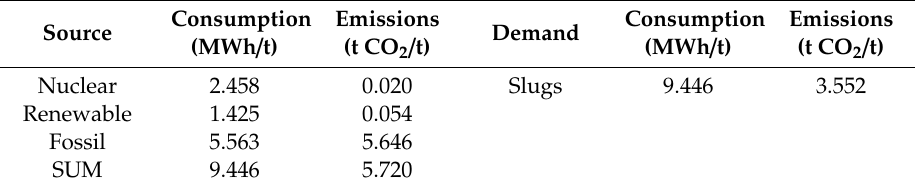
Table 1) of all electricity sources and a much steeper slope compared to renewable and nuclear energy. Table 2. Data required for CEPA.